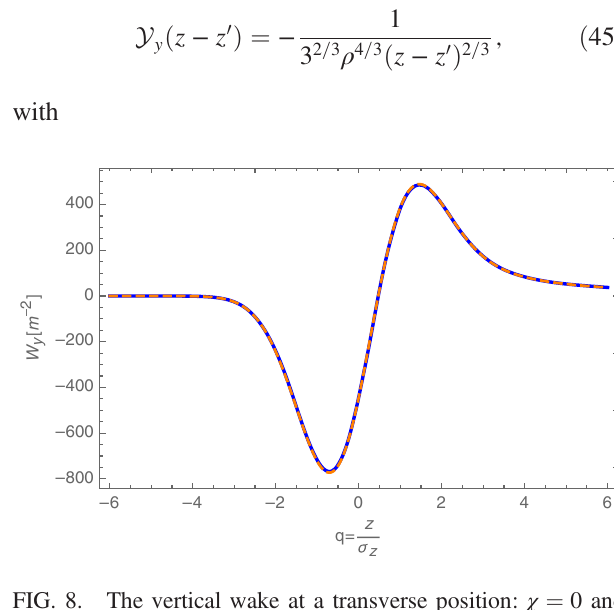
FIG. 8. The vertical wake at a transverse position: χ ¼ 0 and ζ ¼ σ = ρ plotted in blue y